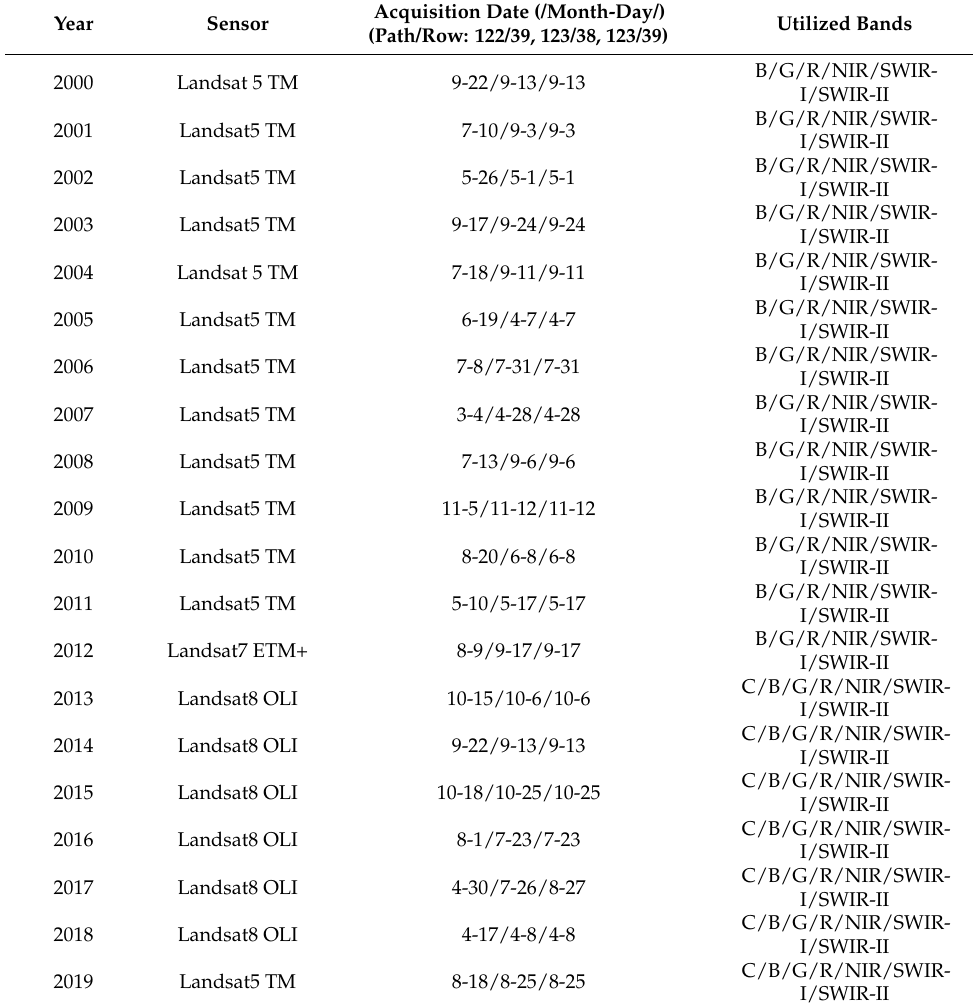
Table 1. Description of Landsat images utilized in this